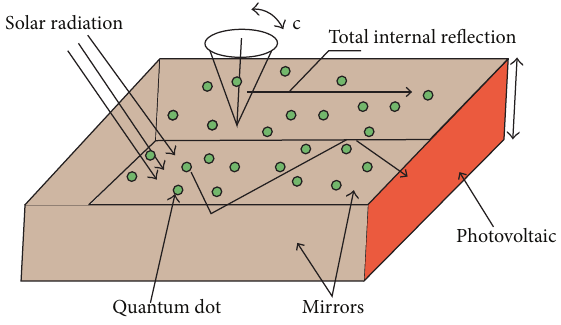
Figure 2: Principle of the QDC